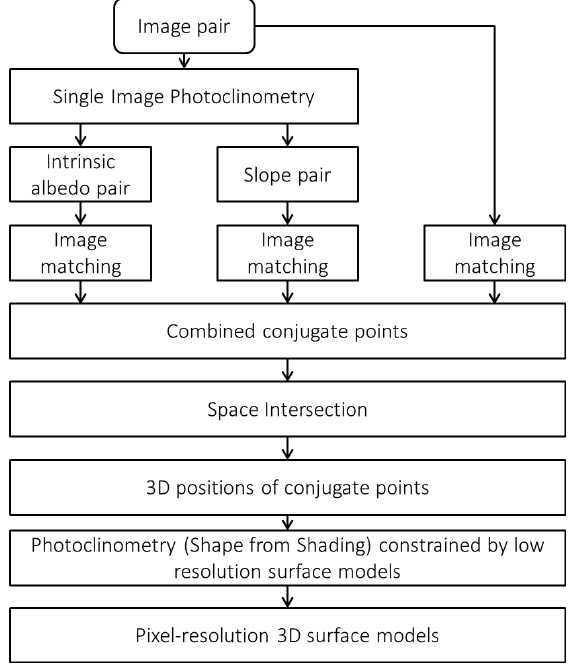
Figure 1. Workflow for the proposed